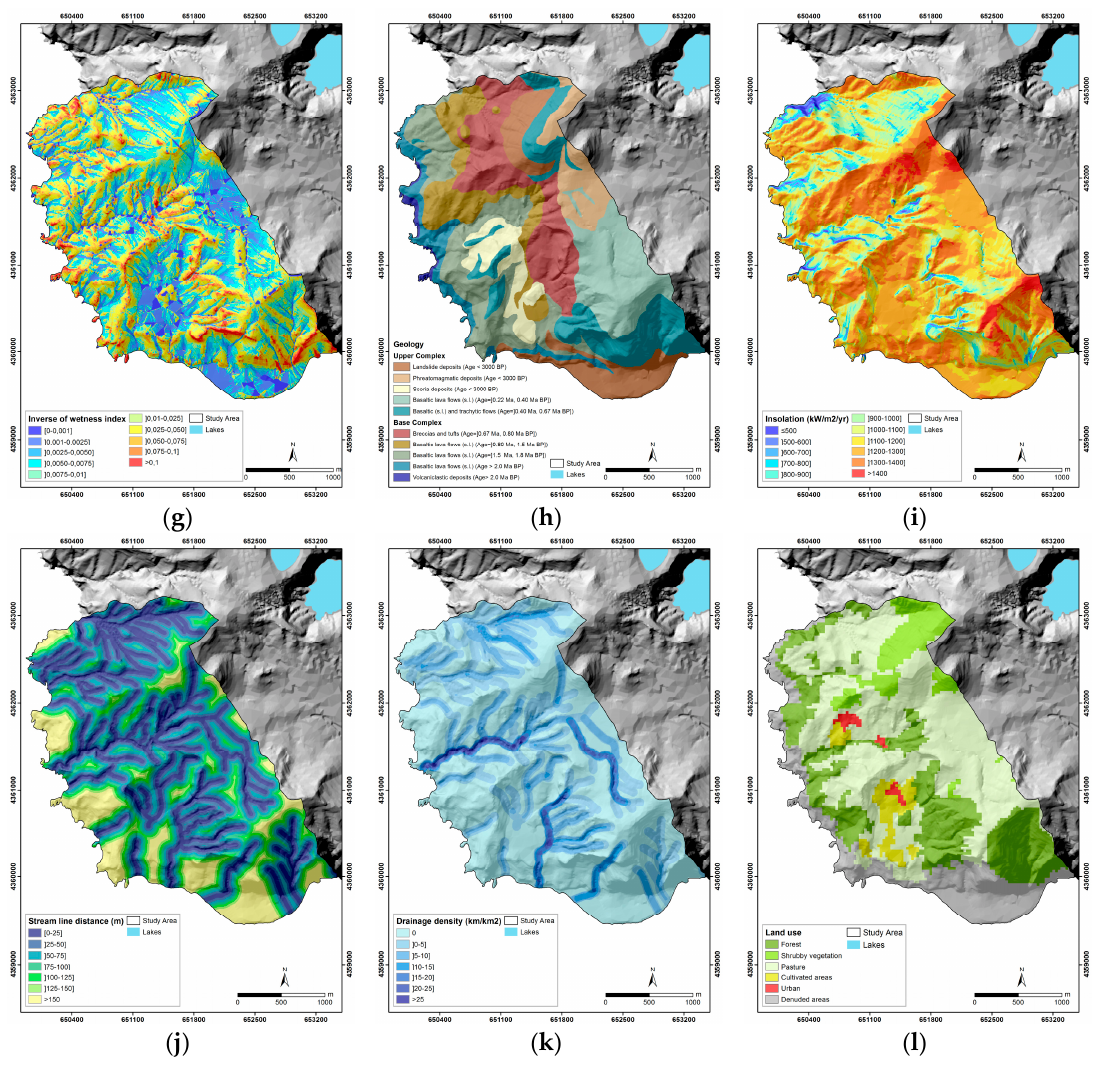
Figure 3. Landslide predisposing factors considered for the susceptibility analysis: ( a ) altitude; ( b ) slope angle; ( c ) slope aspect; ( d ) slope transversal profile; ( e ) slope longitudinal profile; ( f ) contribution area; ( g ) inverse of the wetness index; ( h ) geology; ( i ) insolation; ( j ) stream lines distance; ( k ) drainage density; and ( l ) land use. Table 2. Predisposing factor classes and their Information Values ( Ii ), computed using FALL-TOT ( Ii F-TOT), FALL-MOD ( Ii F-MOD), SLD-TOT ( Ii S-TOT) and SLD-MOD ( Ii S-MOD) as dependent variables.